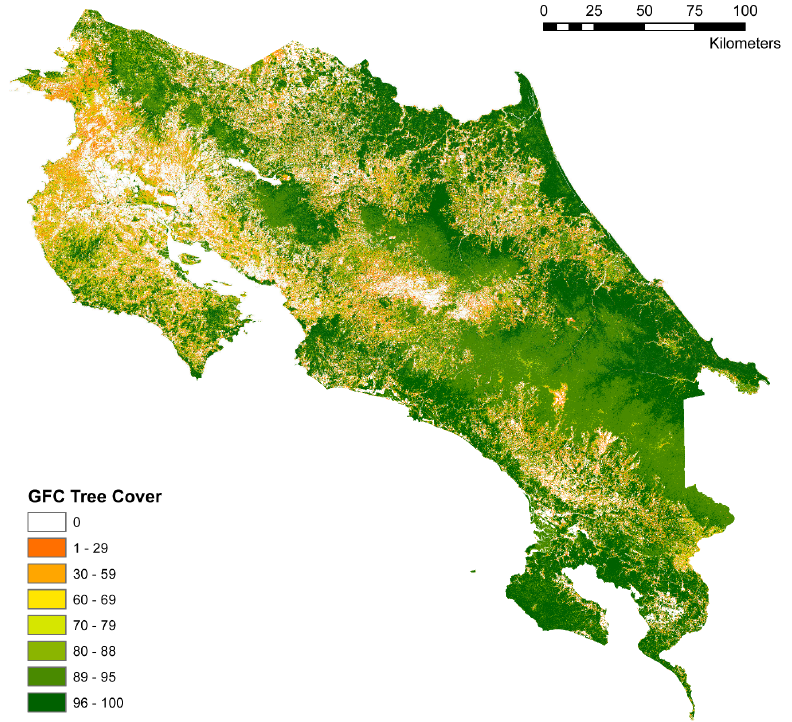
Figure A6. Original GFC estimated tree cover across Costa Rica (2015) displayed to emphasize bias patterns. Note differences in estimated tree cover between the east and west of the country; similar trends do not exist in the reference tree cover data. Remote Sens. 2020 , 12 , 3226